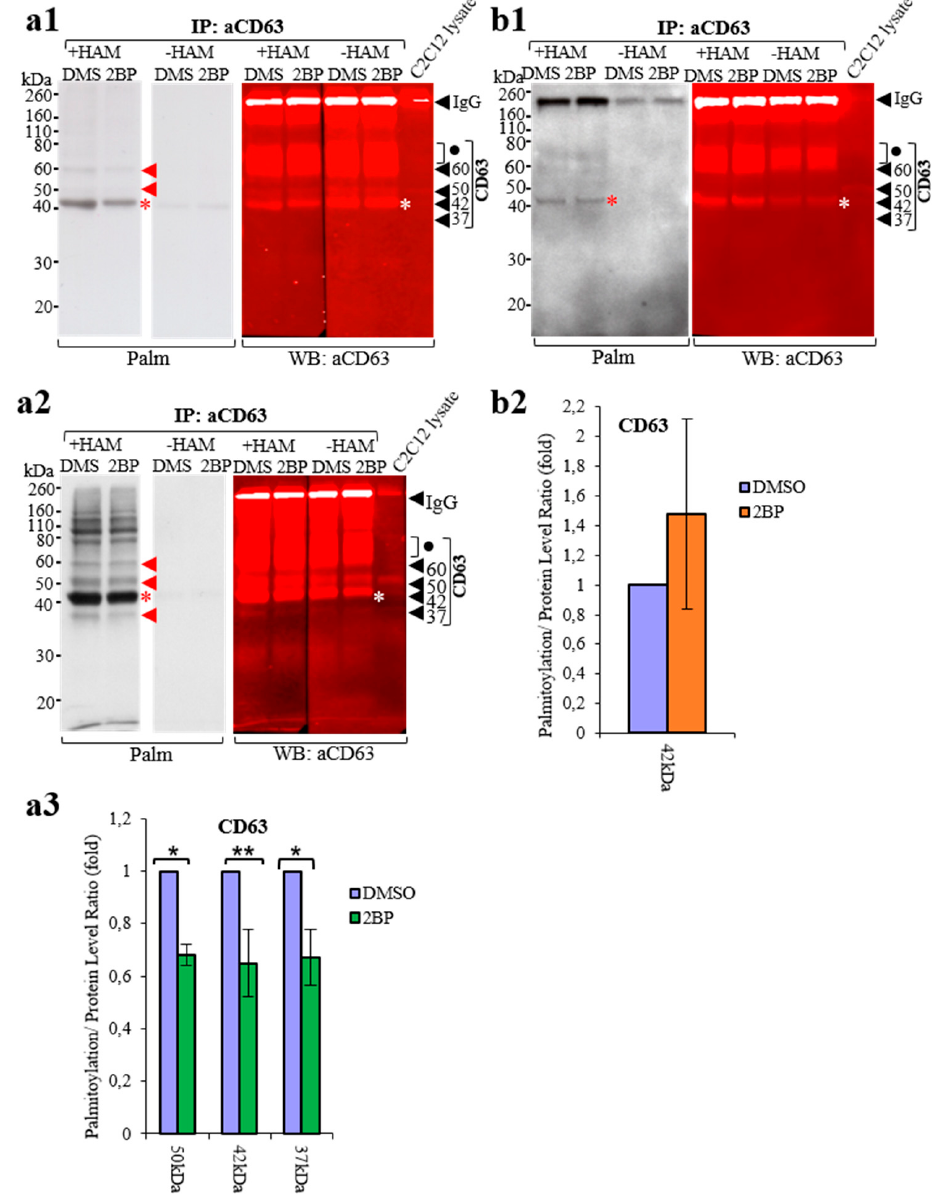
Figure 4. Comparison of ABE using di ff erent protocols. DMSO and 2BP indicate the lanes containing IP from the control and 2BP-treated C2C12 cells. PVDF membranes containing the same pair of DMSO and 2BP immunoprecipitated samples were resuspended with nonreducing sample bu ff er and loaded. The ABE protocol on PVDF ( a ), which came from PAGE-SDS loaded with IP using the CD63 (H193) rabbit polyclonal antibody described in the experimental section , is compared to the ABE protocol carried out on the immunoprecipitated complexes, using the procedure in solution [22] ( b ). IP washes and other common procedures in both experiments, ( a , b ), were performed equally. The experiments in ( a2 ) were performed as in ( a1 ) using a less stringent IP wash in na- tive/mild conditions (see experimental section). Red and white * indicate a prominent palmitoylated 42 kDa band of CD63 that was strongly visible in all experiments ( a1 , b1 , a2 ). Red and black arrows indicate, respectively, palmitoylated and CD63 bands, while dots indicate CD63 bands faintly seen in the C2C12 lysate. Bands of 50, 42 and 37 kDa CD63 were quanti fi ed in the histogram ( a3 ) as the palmitoylation/protein level ratio for DMSO and 2BP treatments, and were referred to experiments performed in ( a2 ), relative to 50 and 37 kDa bands, or in ( a1 ), for the 42 kDa band. The histogram